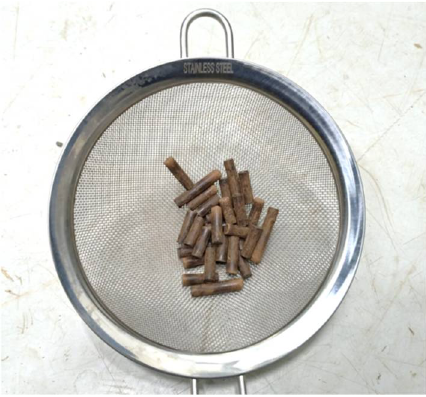
Figure 8. Poplar wood lignin pellets produced from a 6.14% moisture content feedstock and using a single pelletizing system.